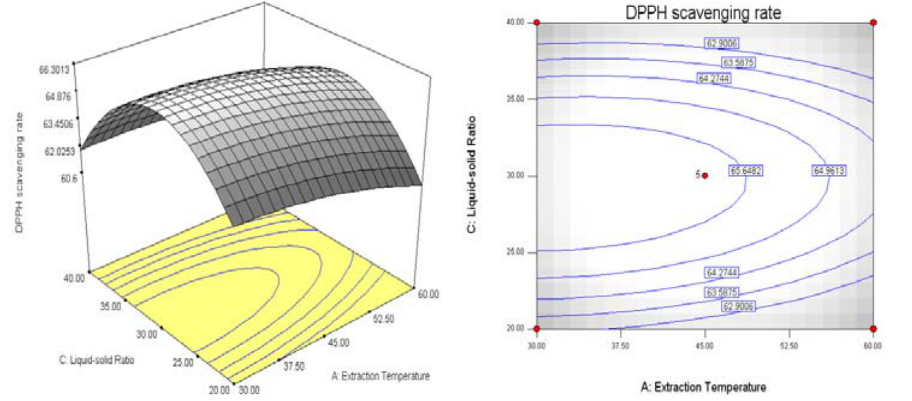
Figure 5. Response surfaces and contour plots showing the effects of extraction temperature and liquid-solid ratio on antioxidant activity Y = (A,